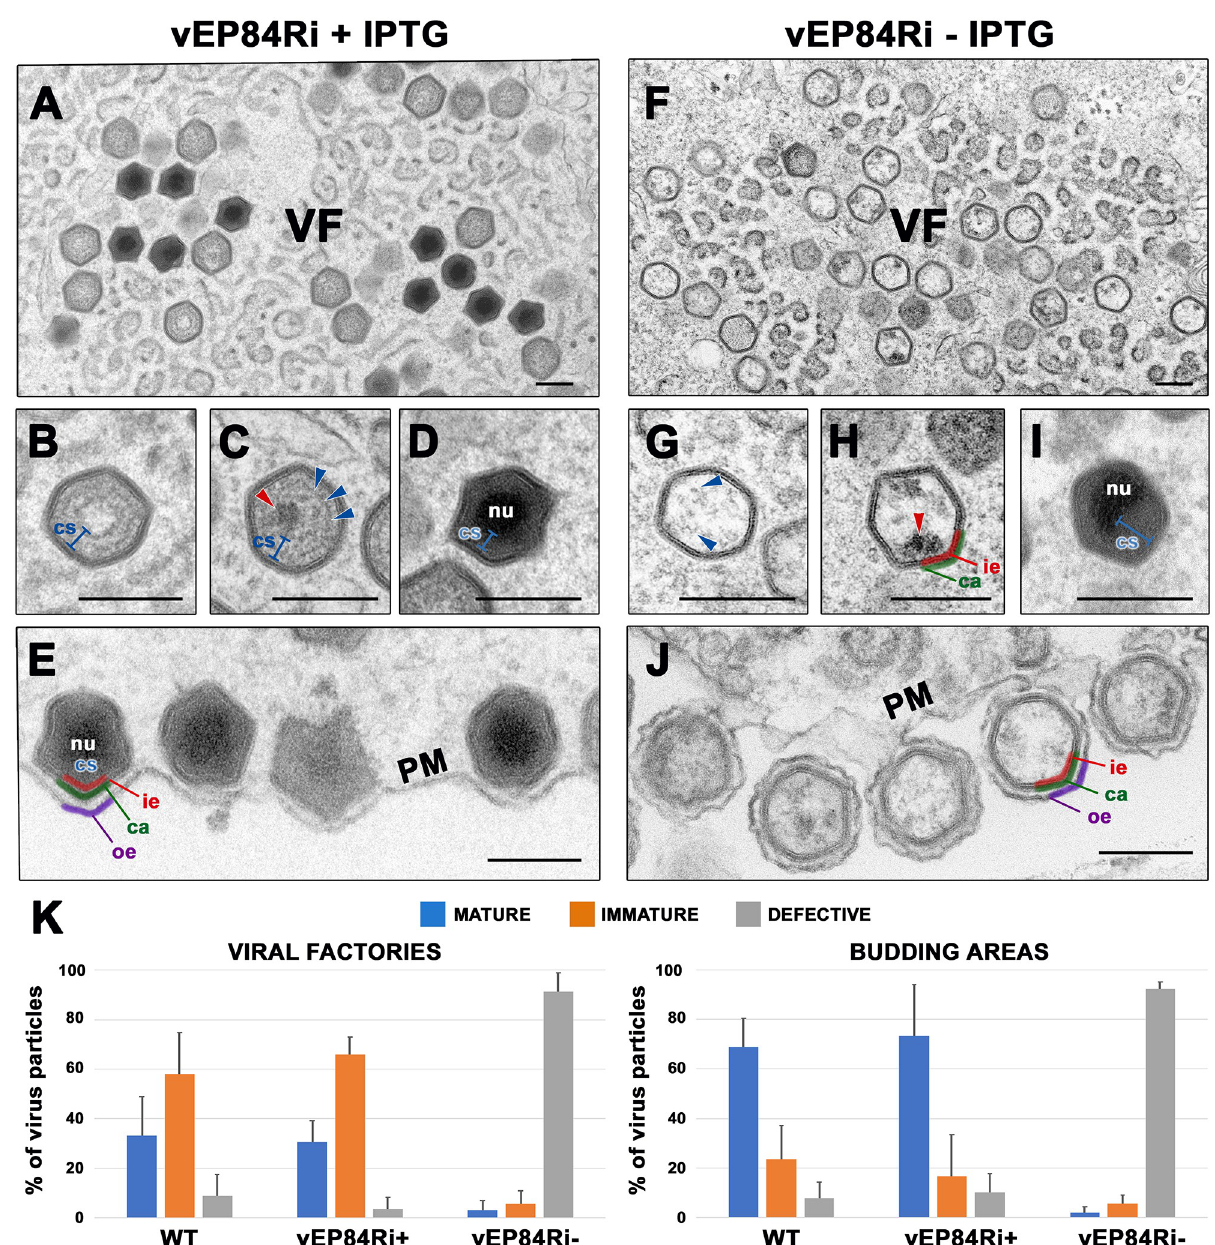
Fig 2. Protein pEP84R is required for core assembly. EM analysis of Vero cells infected with vEP84Ri virus for 20 h in the presence (A-E) or in the absence (F-J) of IPTG. Note that while under permissive conditions (+IPTG), the viral factories (VF) contain significant amounts of mature particles (A) , under non-permissive conditions (-IPTG), they contain essentially icosahedral empty particles (F) . Thus, whereas control vEP84Ri + intermediates (B, C) contain a well-organized core shell (cs), consisting of a ~30-nm thick domain divided by a thin electron-dense layer (blue arrowheads in C ), and sometimes also a centered developing nucleoid (nu, red arrowhead in C ), the core region of vEP84Ri - particles appear mostly empty, containing disorganized particulate material (blue arrowheads in G ) and eventually an electron-dense incipient nucleoid (red arrowhead in H ) attached to the inner envelope (ie, red). A minor population of the defective icosahedral viruses contained an acentric dense and large nucleoid surrounded by an asymmetric core shell (I) . Note also that vEP84Ri - particles contain a normal outer capsid (ca, green) and acquire their outer envelope (oe, purple) by budding (J) at PM, as occurs with vEP84Ri + particles (E) . Bars, 200 nm. (K) Quantification of mature, immature and defective vEP84Ri particles detected at 20 hpi under permissive (+) and non-permissive (-) conditions. The percentage of each virus category for each condition was estimated both in virus factories and budding areas. As a reference, wild type infections were also analyzed.